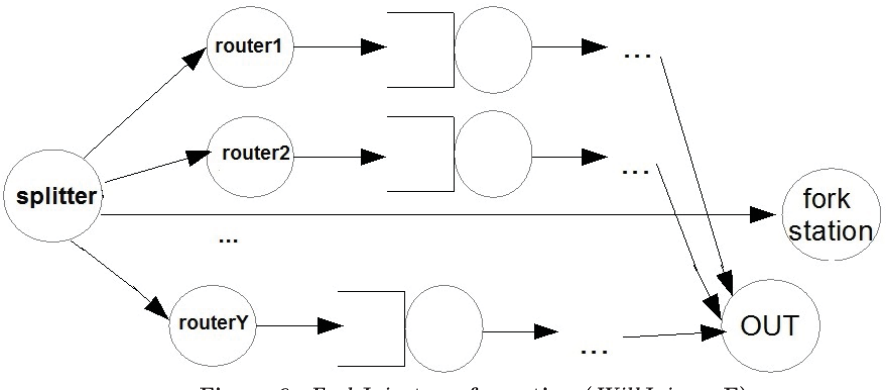
Figure 6: ForkJoin transformation ( WillJoin =